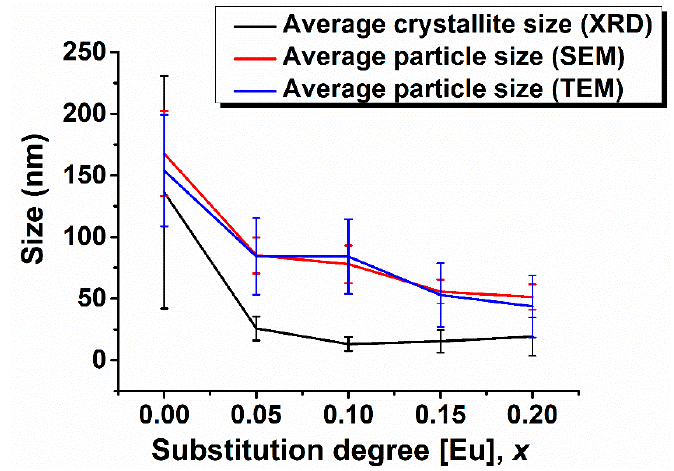
Figure 10. Comparison between average crystallite size determined from XRD data and average particle size measured from SEM and TEM images.